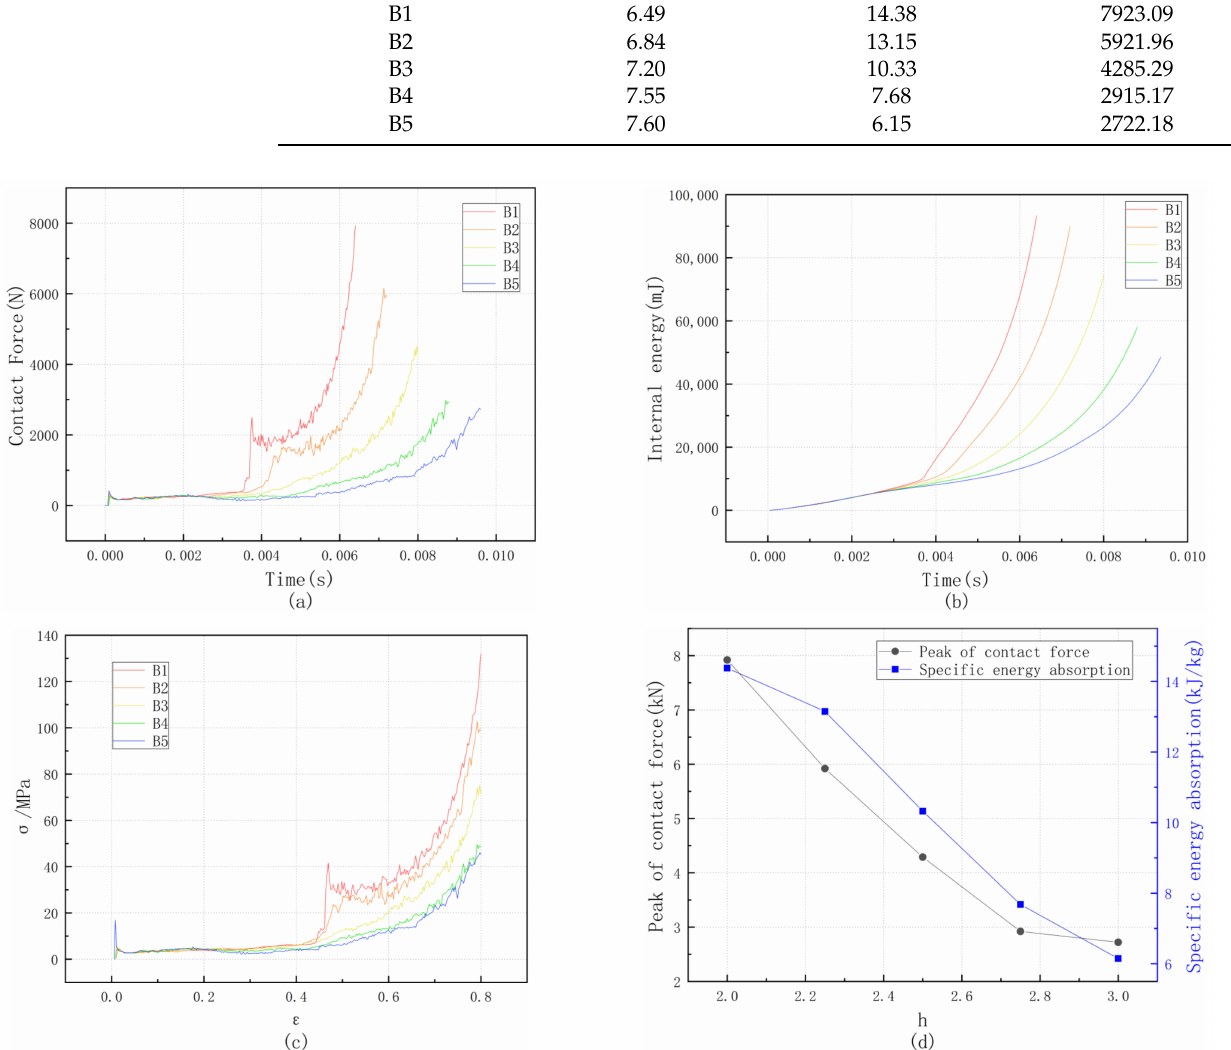
Figure 15. ( a ) Effect of different h on force; ( b ) effect of different h on energy; ( c ) effect of different h on stress–strain curve; ( d ) effect of different h on peak crushing force and specific absorption energy.